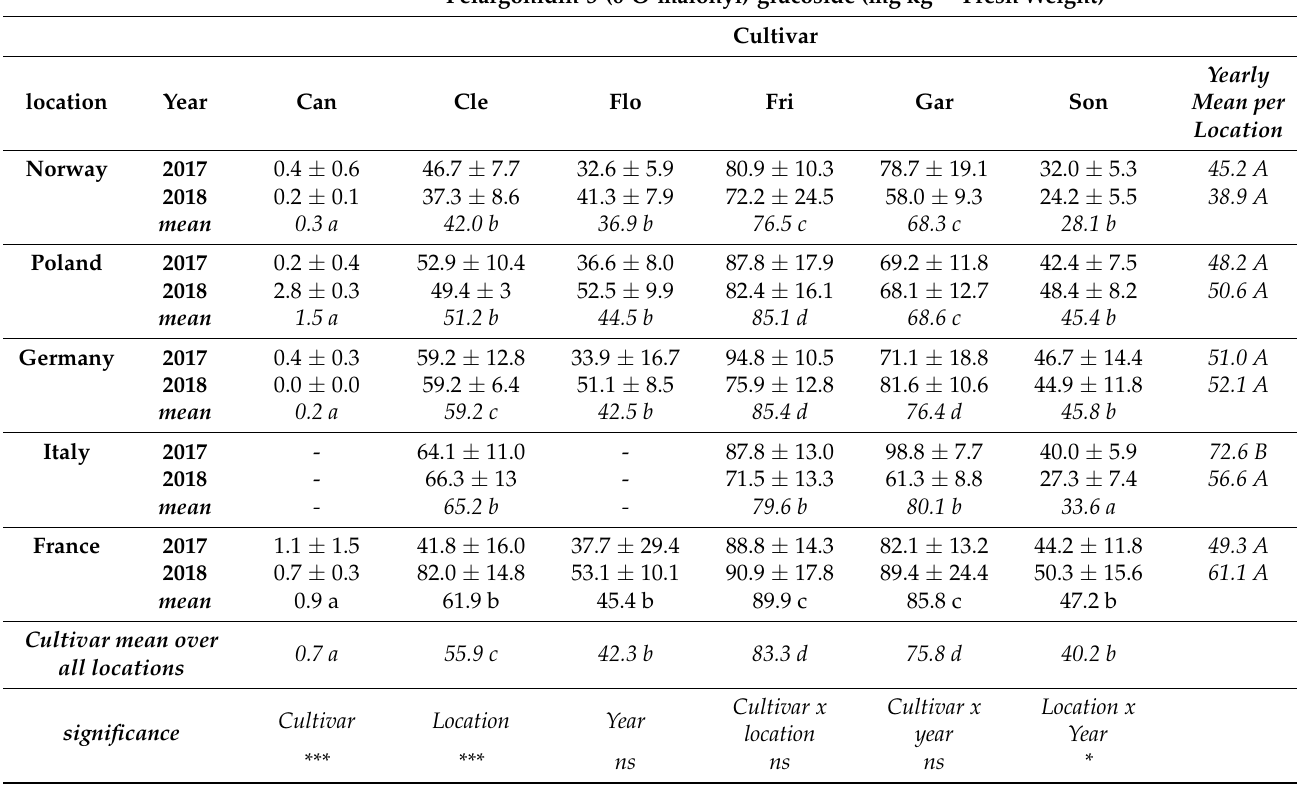
Table 7. Effect of growing location and year on pelargonidin-3-(6-O-malonyl)-glucoside content as the mean of two picking dates in fruits of six strawberry